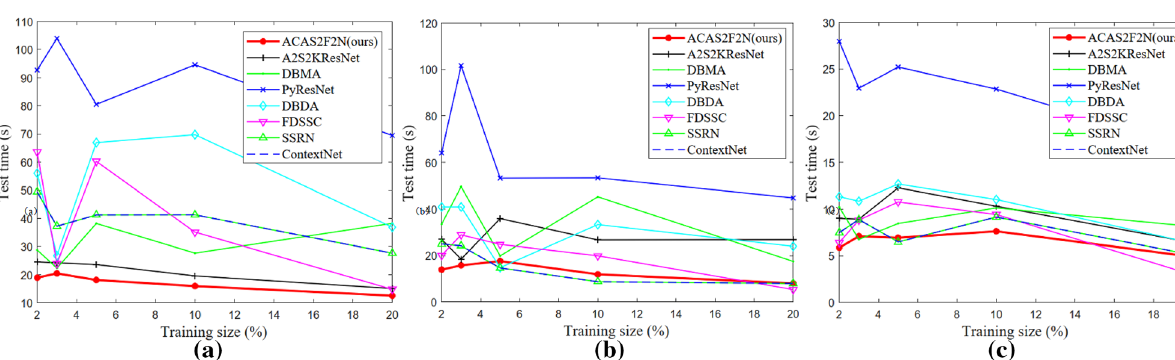
Figure 11. Test time under different training sizes. ( a ) IP dataset. ( b ) KSC dataset. ( c ) Botswana